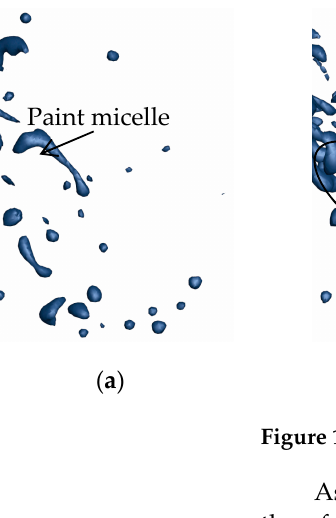
Figure 14. Formation process of paint droplets: ( a ) 2.084 ms, ( b ) 2.098 ms, ( c ) 2.107 ms, and ( d ) 2.118 ms.